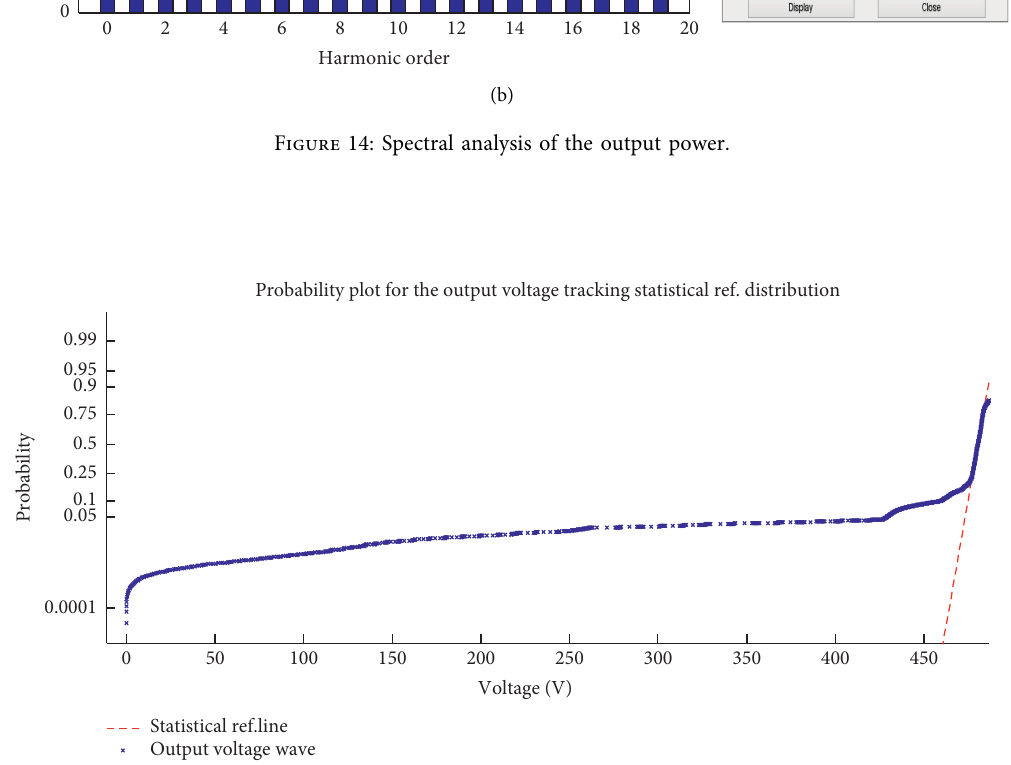
Figure 15: Output voltage versus statistical reference line.